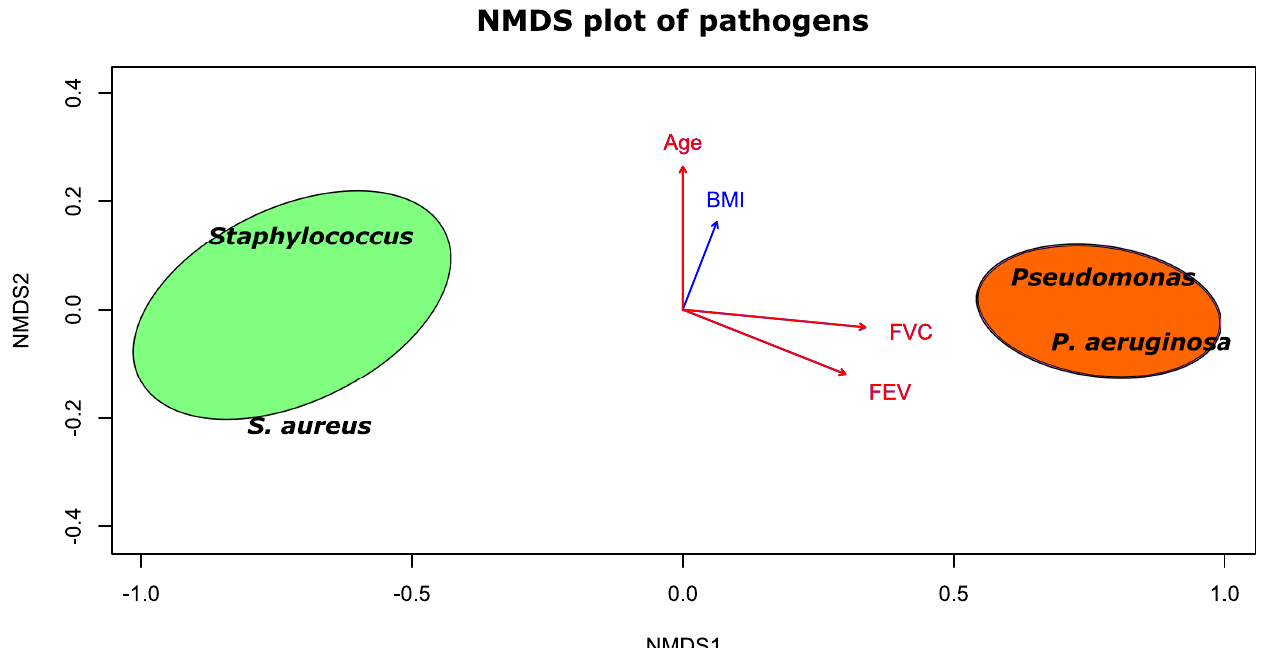
Fig 5. Non-metric Multidimensional Scaling (NMDS) plot showing significant correlations ( P < 0.05) between microbiota and clinical variables in the Staph group. The ellipses encompass different groups, with the Staph group in green and Pseud group in orange. Taxa are shown in black and clinical variables in red and blue vectors (red means significant). The direction of the vectors FEV and FVC indicates an inverse relationship with bacteria present in high quantities in the Staph group, n = 20 per group.